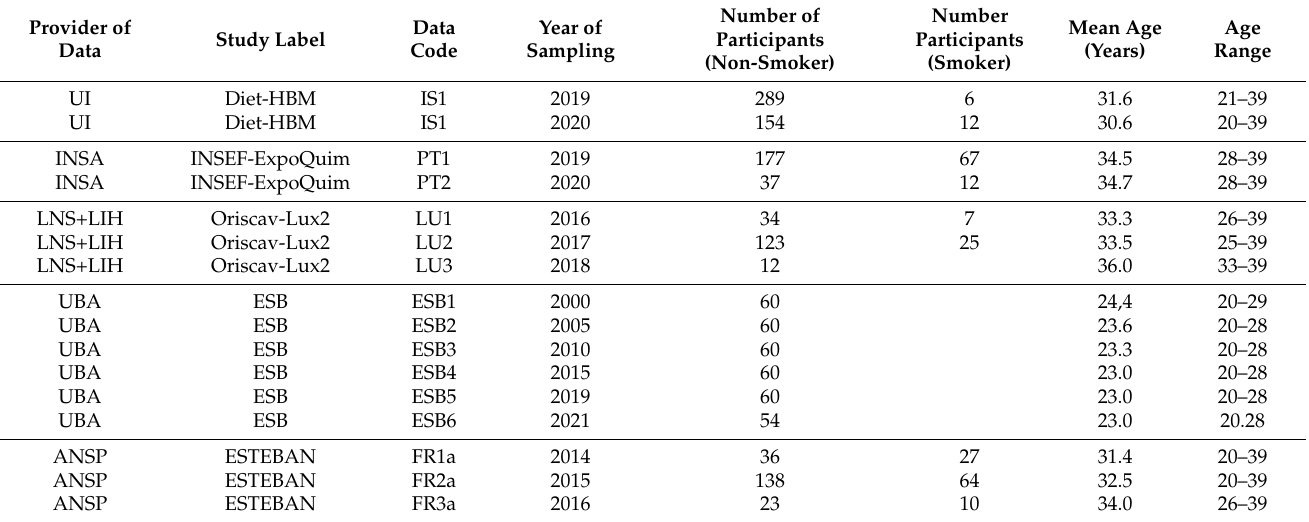
Table 2. Overview of HBM4EU-aligned studies and data sources based on bilateral agreements performing biomonitoring acrylamide metabolites, performed between 2000 and 2021 in